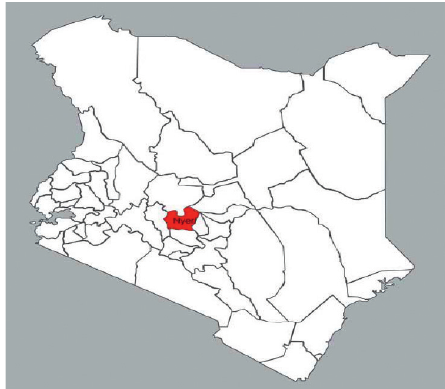
Figure 1: Map of Kenya showing Nyeri County (red). Map courtesy of